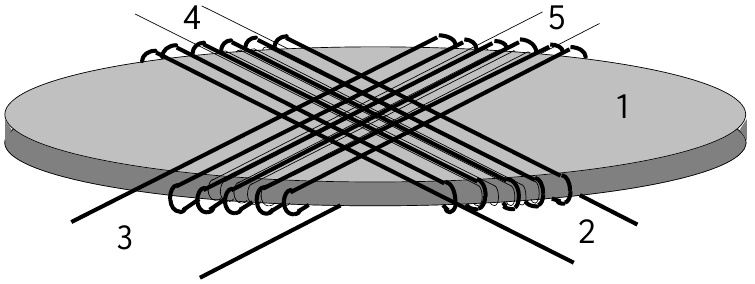
Figure 10. Schematic view of two-axis sensor unit. 1: Amorphous disc. 2/3: Orthogonal primary coils. 4/5: Orthogonal pick-up coils